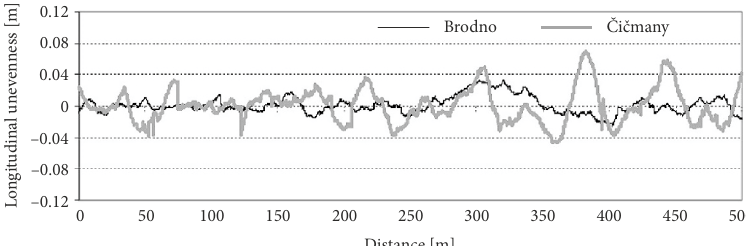
Figure 6. Profile elevations measured by geodetic survey on road sections called Brodno and Čičmany